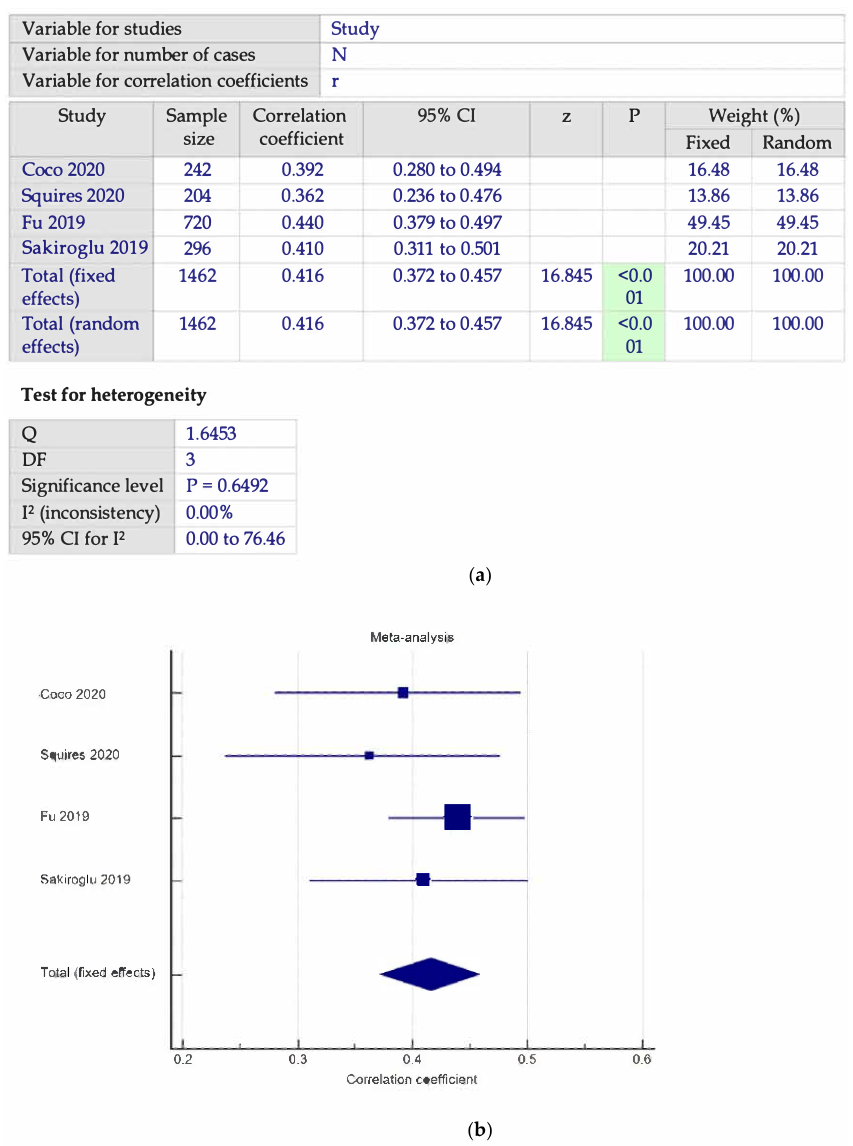
Figure 2. ( a ) Meta-analysis on DERS-SAS subgroup [48,51,53,65]; ( b ) forest plot showing the relation- ship between emotional dysregulation and PSU in studies using DERS and SAS scales